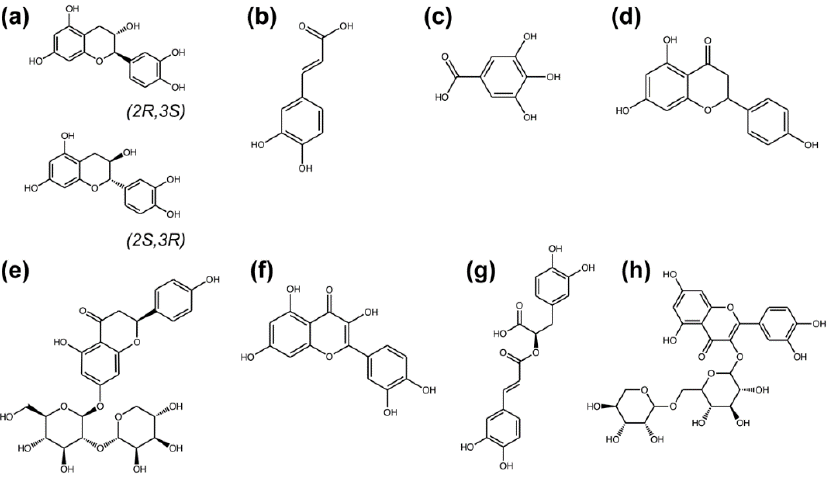
Figure 1. Chemical structures of phenolic compounds in the guava leaf extract that were detected by liquid chromatography – mass spectrometry: ( a ) catechin comprising of (+)-catechin (2R,3S) and (−) -catechin (2S,3R); ( b ) caffeic acid; ( c ) gallic acid; ( d ) naringenin; ( e ) naringin; ( f ) quercetin; ( g ) rosmarinic acid; ( h ) rutin. All chemical structures were acquired from PubChem database [27] and visualized by ChemDraw (version 22, PerkinElmer Informatics).